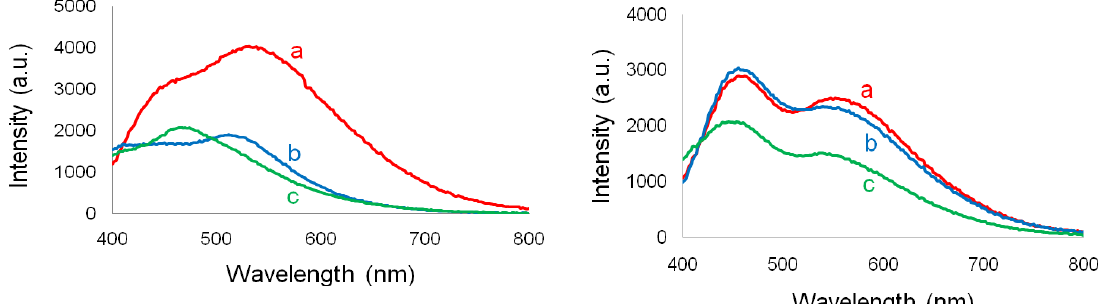
Figure 12. Left: Fluorescence spectra of the supernatant solutions of ZnO NPs obtained with 1% ( a ), 2.5% ( b ), and 5% ( c ) PyQAs1. Right: Fluorescence spectra of the supernatant solutions of ZnO NPs obtained with 1% ( a ), 2.5% ( b ), and 5% ( c ) PyQAs2. Excitation wavelength: 365 nm.